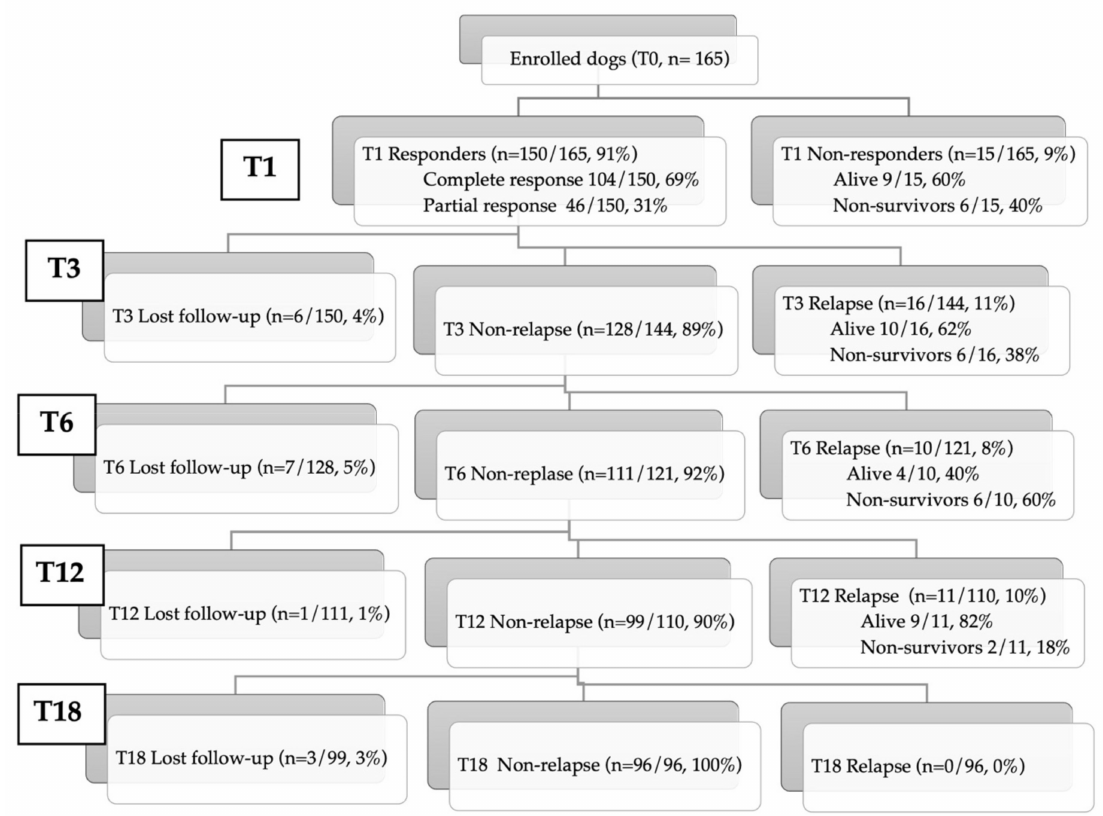
Figure 1. Flow diagram of inclusion (T0; 165 dogs) and clinical follow-up at various timepoints (T1, T3, T6, T12, T18 months) in immunosuppressant-responsive and non-responsive enteropathy